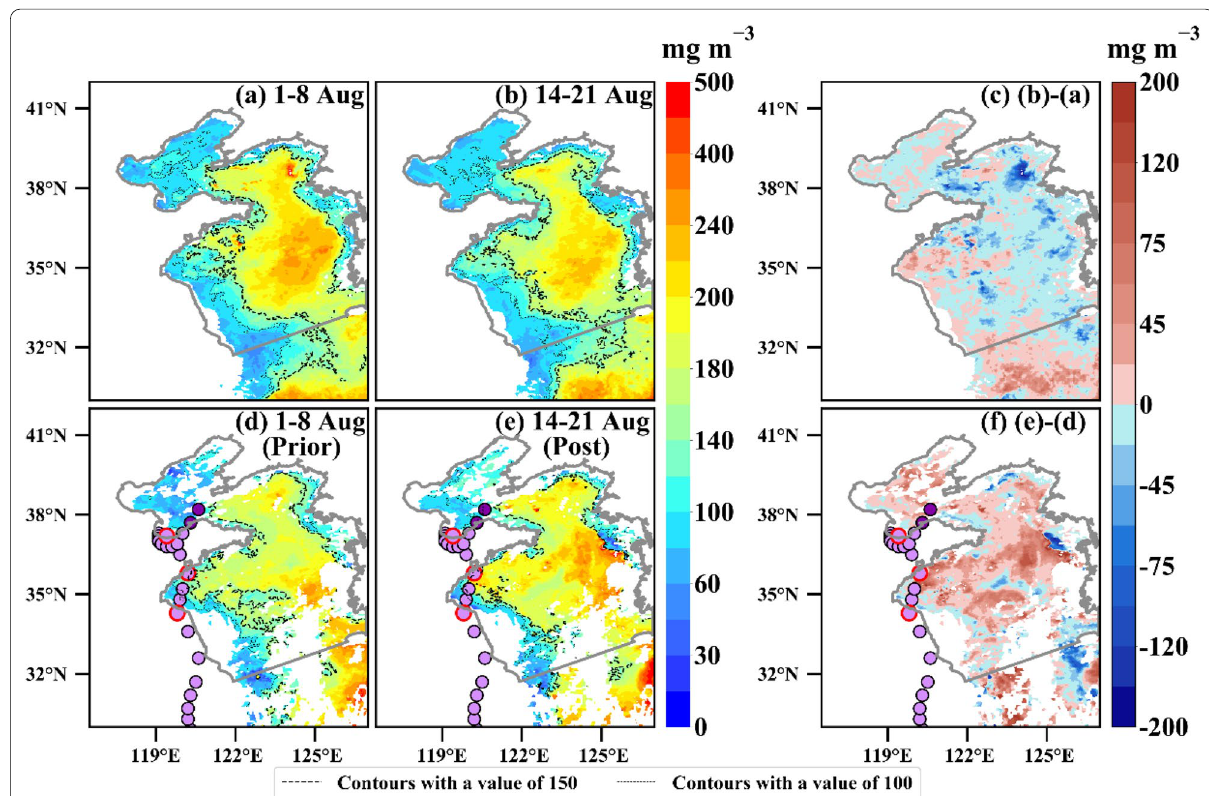
Fig. 6 POC:Chl‑a ratio during 1–8th August ( a , d ), 14–21st August ( b , e ), and the difference ( c , f ) between the two periods for non‑typhoon years (top panel) and 2019 (lower panel) in the Yellow‑Bohai